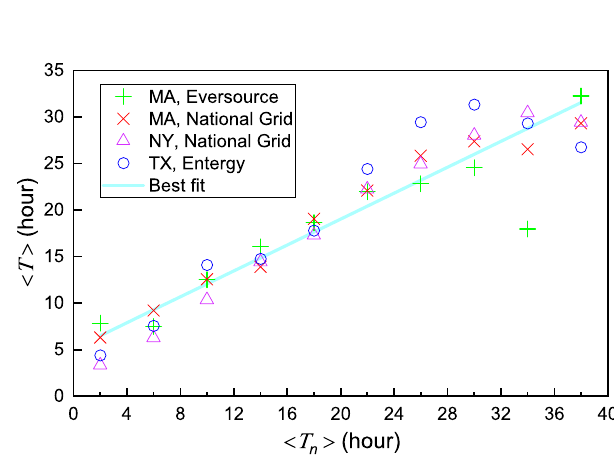
Fig. 3 | Correlation between outages and their nearby outages on recovery duration. The average recovery duration of outages 〈 T 〉 versus that of their geo- graphically nearest n outages 〈 T n 〉 . The data are taken from four blackouts across the United States. Speci fi cally, two MA blackouts that began on 25 February 2019 are reported from Eversource and National Grid, respectively; the NY blackout occurred a day before MA blackouts, and the TX data was recorded by Entergy on 25 October 2019. Without loss of generality, we set n = 5 as the results are insen- sitive to the choice of n (Supplementary Fig.